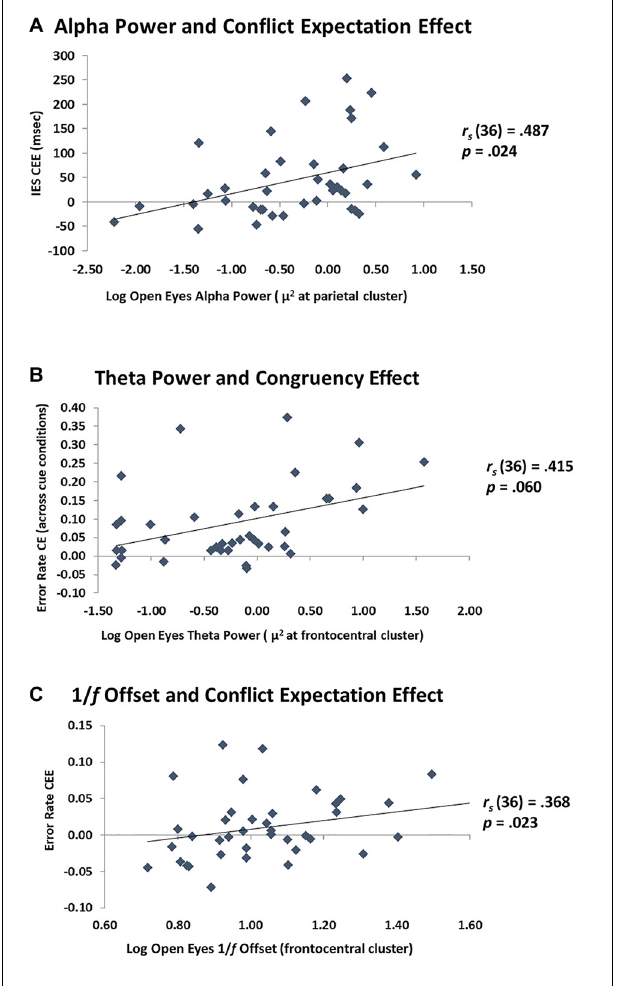
FIGURE 5 | Relationship between EEG and cognitive control. (A) Scatterplot of parietal alpha power with the CEE on the inverse efficiency score (IES). The greater the alpha power, the more these individuals used the cue information (proactive control). (B) Scatterplot of frontocentral theta power with the CE on error rate. The greater the theta power at rest, the greater the distractor interference (reactive control). (C) Scatterplot of frontocentral 1/ f offset with the CEE on error rate. The steeper the 1/ f offset, the more these individuals used the cue information (proactive